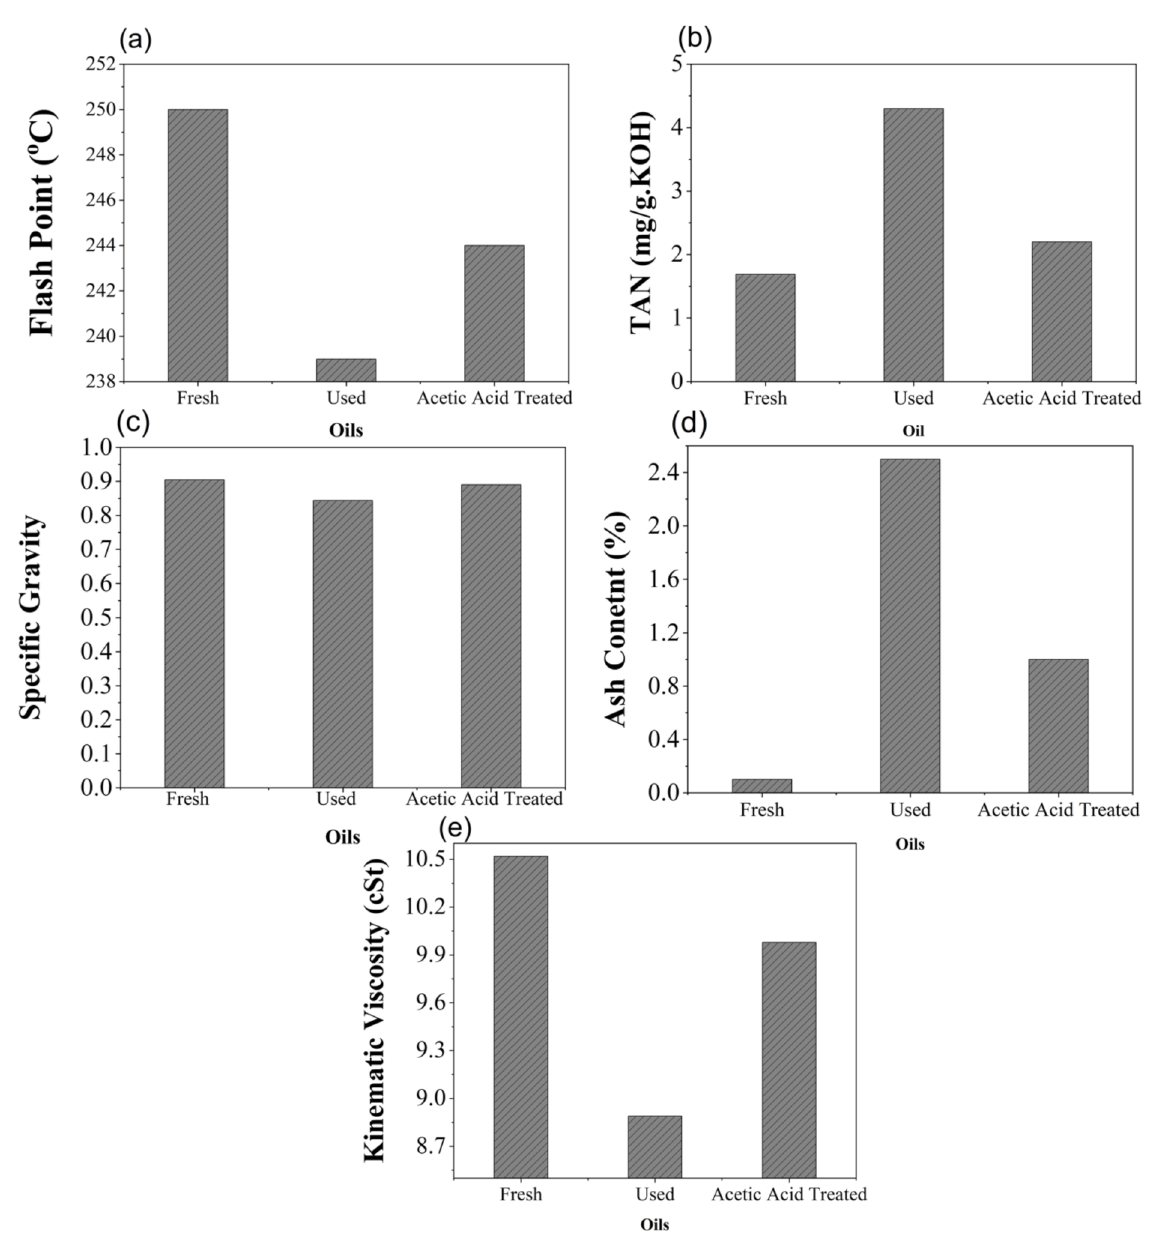
Figure 4. Comparison of ( a ) flashpoint ( b ) TAN ( c ) specific gravity ( d ) ash content ( e ) kinematic viscosity of fresh, used, and regenerated lubricating